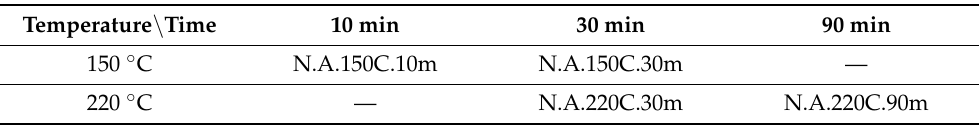
Table 1. Abbreviations of nickel acetate-derived nickel hydroxide samples (N.A.) at different temper- atures and